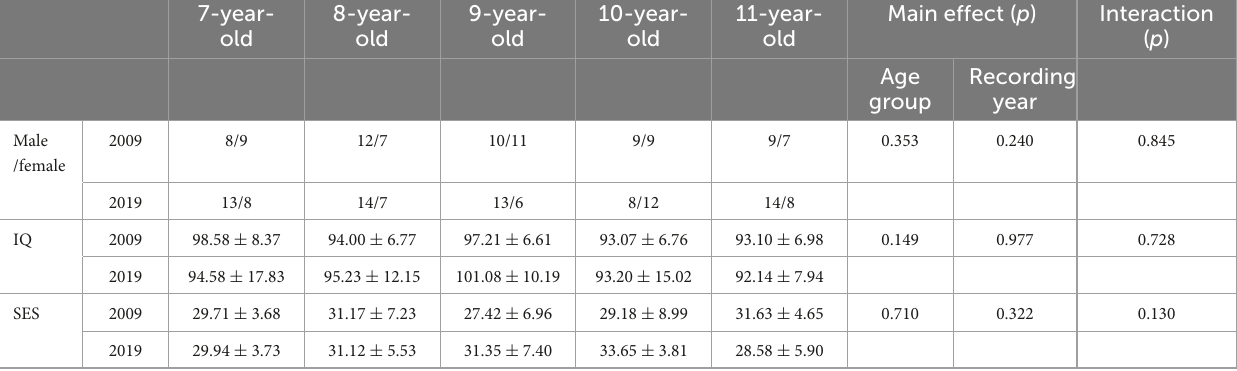
TABLE 1 Demographic information of children in the final